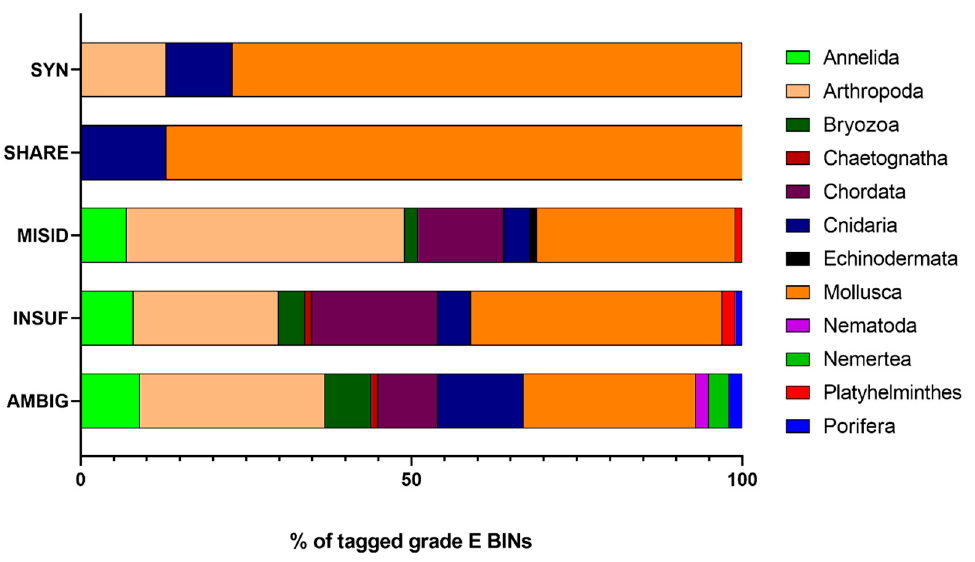
Figure 5. Percentual taxonomic composition of the tagged graded E BINs. AMBIG: ambiguous rec- ords, INSUF: insufficient records, MISID: misidentifications, SYN: synonyms, and SHARE: when the BIN system was not able to discriminate well-established species. Chordata only includes Asci- diacea.